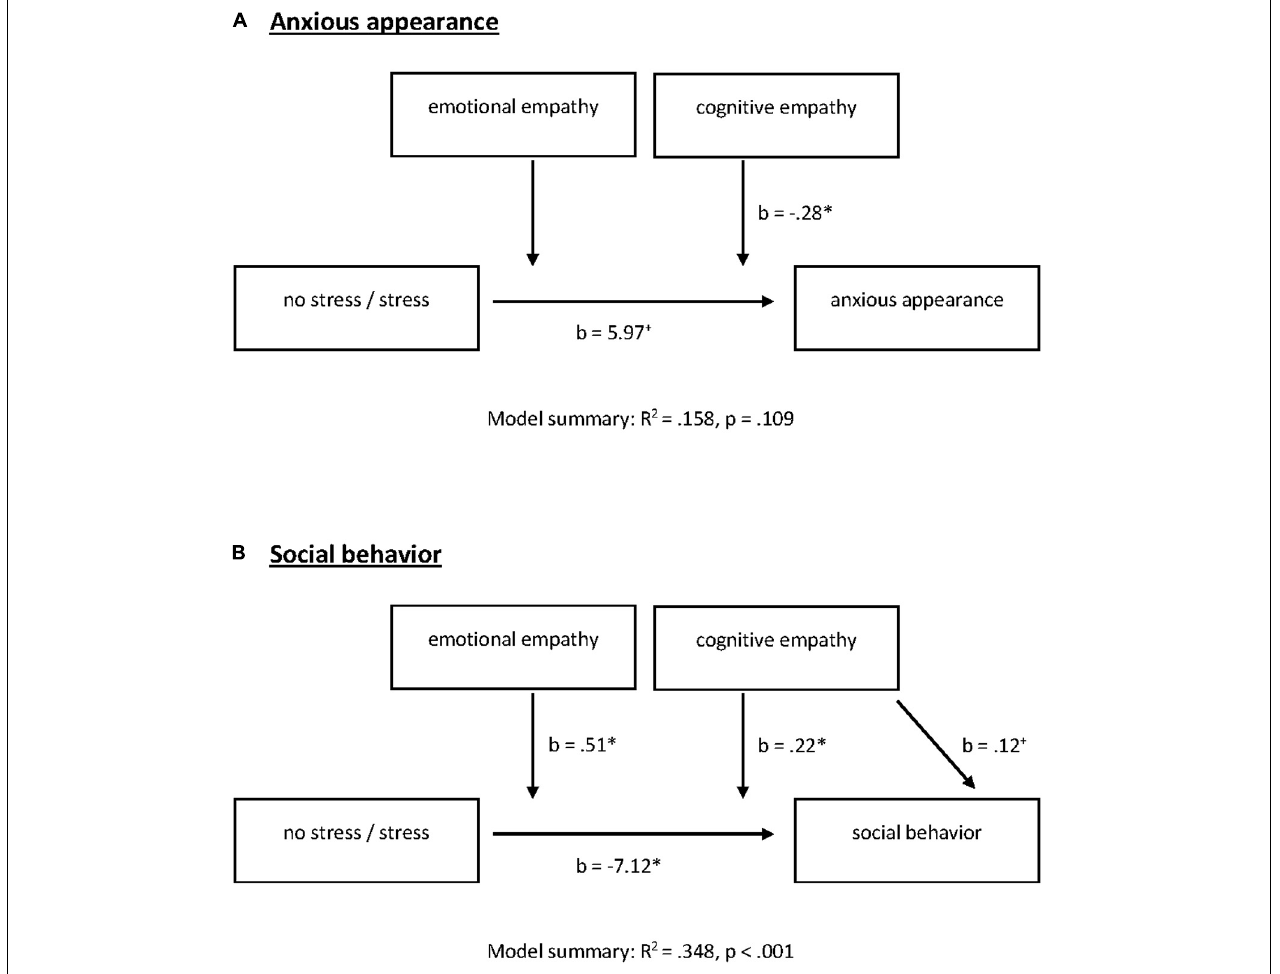
FIGURE 4 | Emotional and cognitive empathy as moderators for acute stress effects on (A) anxious appearance and (B) social behavior in the post-stress conversation in participants with SAD. + p = 0.100, ∗ P = 0.050.